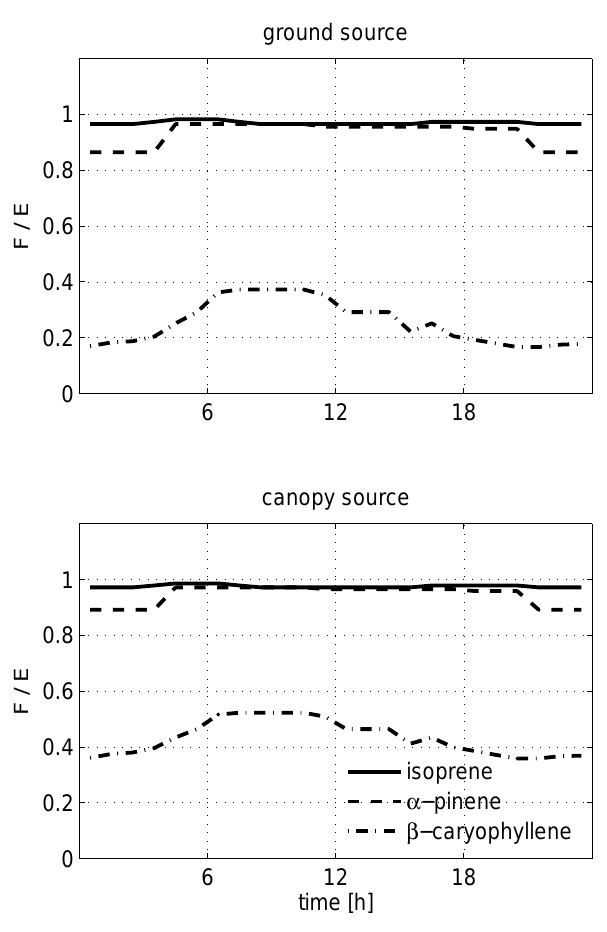
Fig. 8. Diurnal cycle of the flux-to-surface-exchange ( F / E ) ratios of isoprene, α -pinene and β -caryophyllene for conditions during HUMPPA-COPEC-2010